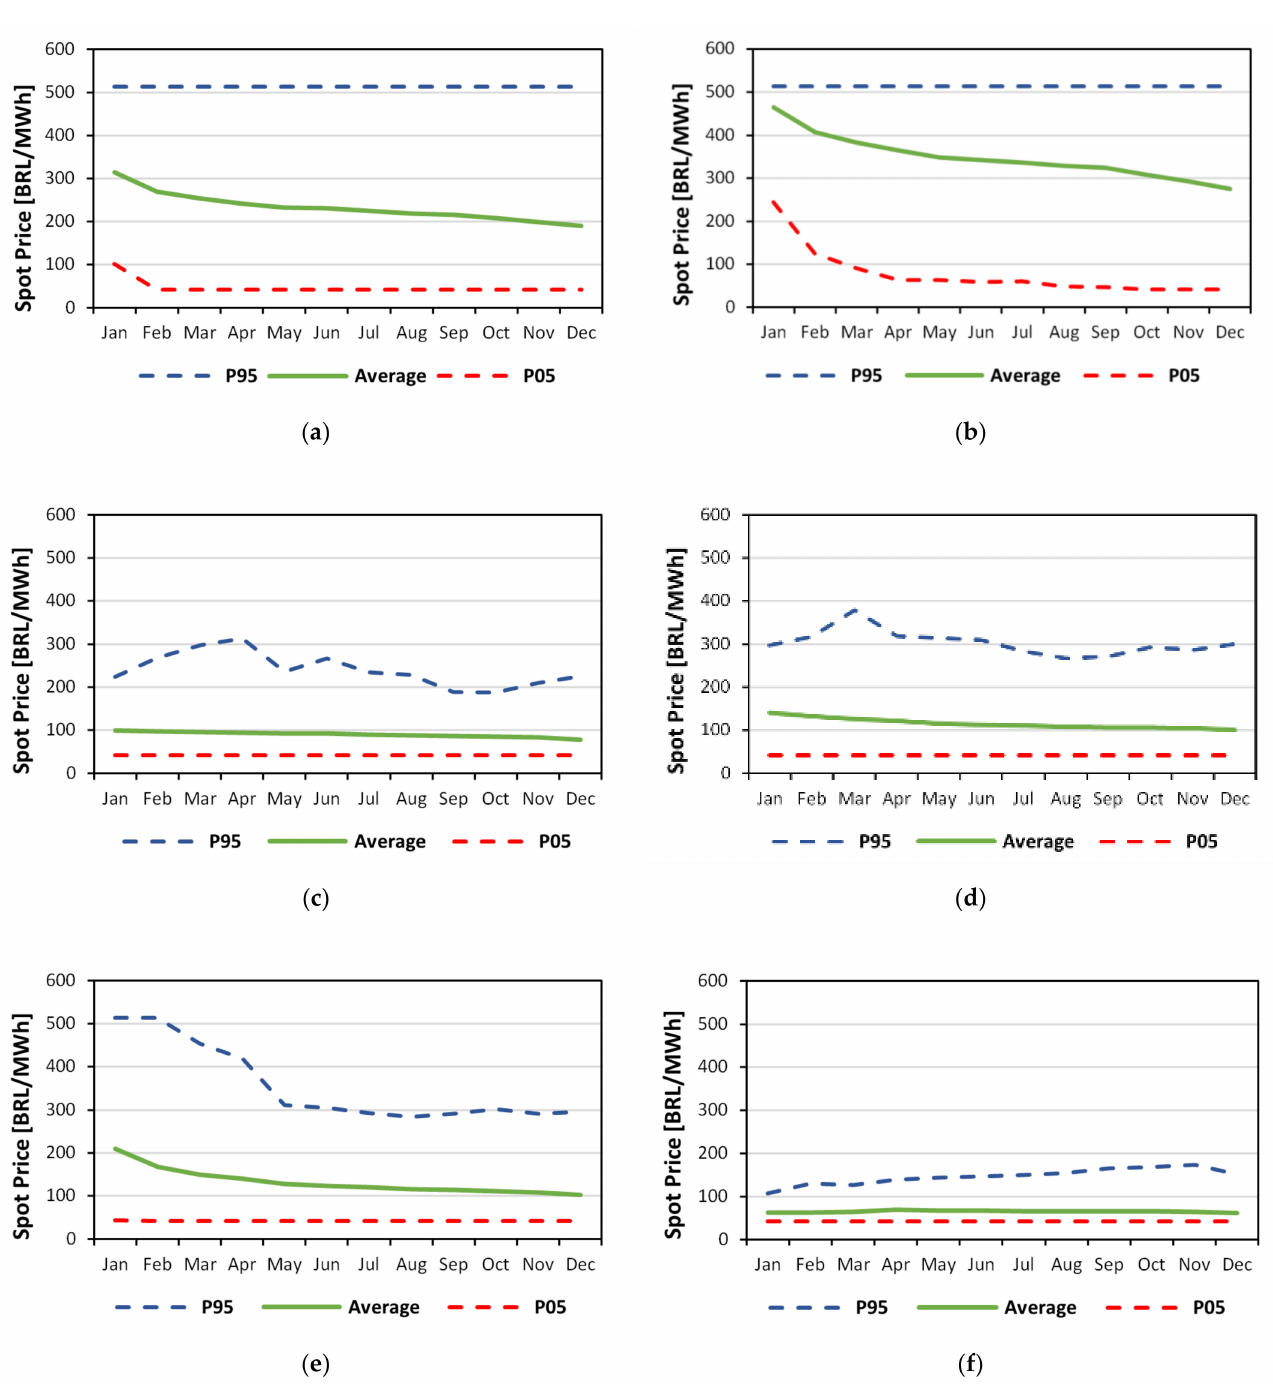
Figure 3. NEWAVE spot price forecasts for the years: ( a ) 2014; ( b ) 2015; ( c ) 2016; ( d ) 2017; ( e ) 2018; and ( f )